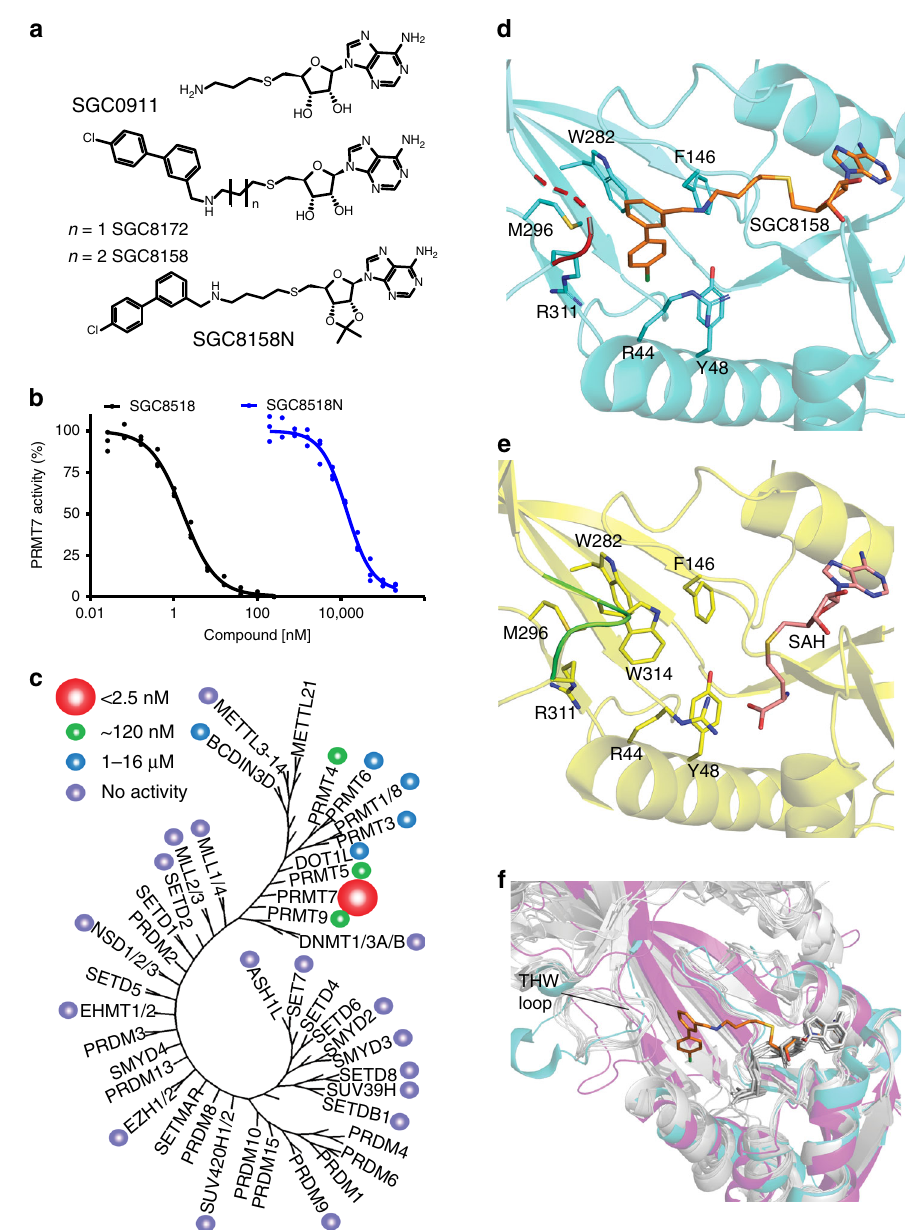
Fig. 1 SGC8158 is a potent and selective PRMT7 inhibitor in vitro. a Structures of HTS hit compound SGC0911, potent compound SGC8172, active component of the chemical probe SGC8158 and its negative control SGC8158N. b SGC8158 inhibits PRMT7 in vitro with IC 50 of <2.5 nM, whereas negative control compound SGC8158N has IC 50 of 14 ± 2 μ M, ( n = 3 biological replicates, mean ± SEM). c SGC8158 is selective against a panel of 35 proteins, DNA, and RNA methyltransferases. IC 50 values are represented by colored circles indicated top left of the panel. d Crystal structure of MmPRMT7 in complex with SGC8158. MmPRMT7 is shown in cartoon representation in cyan, hydrophobic pocket residues are shown in cyan sticks, and SGC8158 is in orange. The THW motif loop region is highlighted in red with dashed lines representing the unmodeled H313 and W314 residues. e For comparison, the crystal structure of MmPRMT7_SAH (PDB ID: 4C4A) is shown in cartoon representation in yellow, hydrophobic pocket residues are shown in yellow sticks, and SAH is in pink. The THW motif loop region is highlighted in green. f Comparison of the THW motif loop region of MmPRMT7_SGC8158 (in cyan) with that of PRMT5 (PDB ID: 5GQB) (in magenta), and PRMT1, 2, 3, 4, 6, and 8 (in gray) (PDB IDs: 1OR8, 5FUL, 2FYT, 2V74, 4Y30, and 5DST, respectively). SGC8158 is shown in orange sticks and SAH in gray sticks. Source data are provided as a Source Data fi